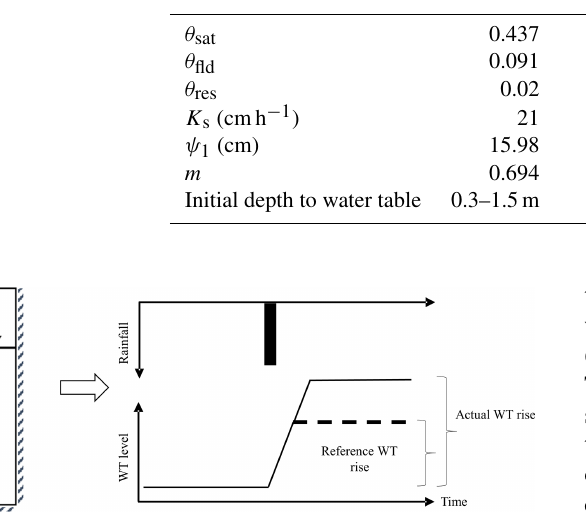
Figure 3. Schematic representation of actual and reference water table rise using the WTF method for a soil column subjected to a single pulse of rainfall. In this case the actual water table rise is larger than the reference value, which occurs when the water table is very close to the soil